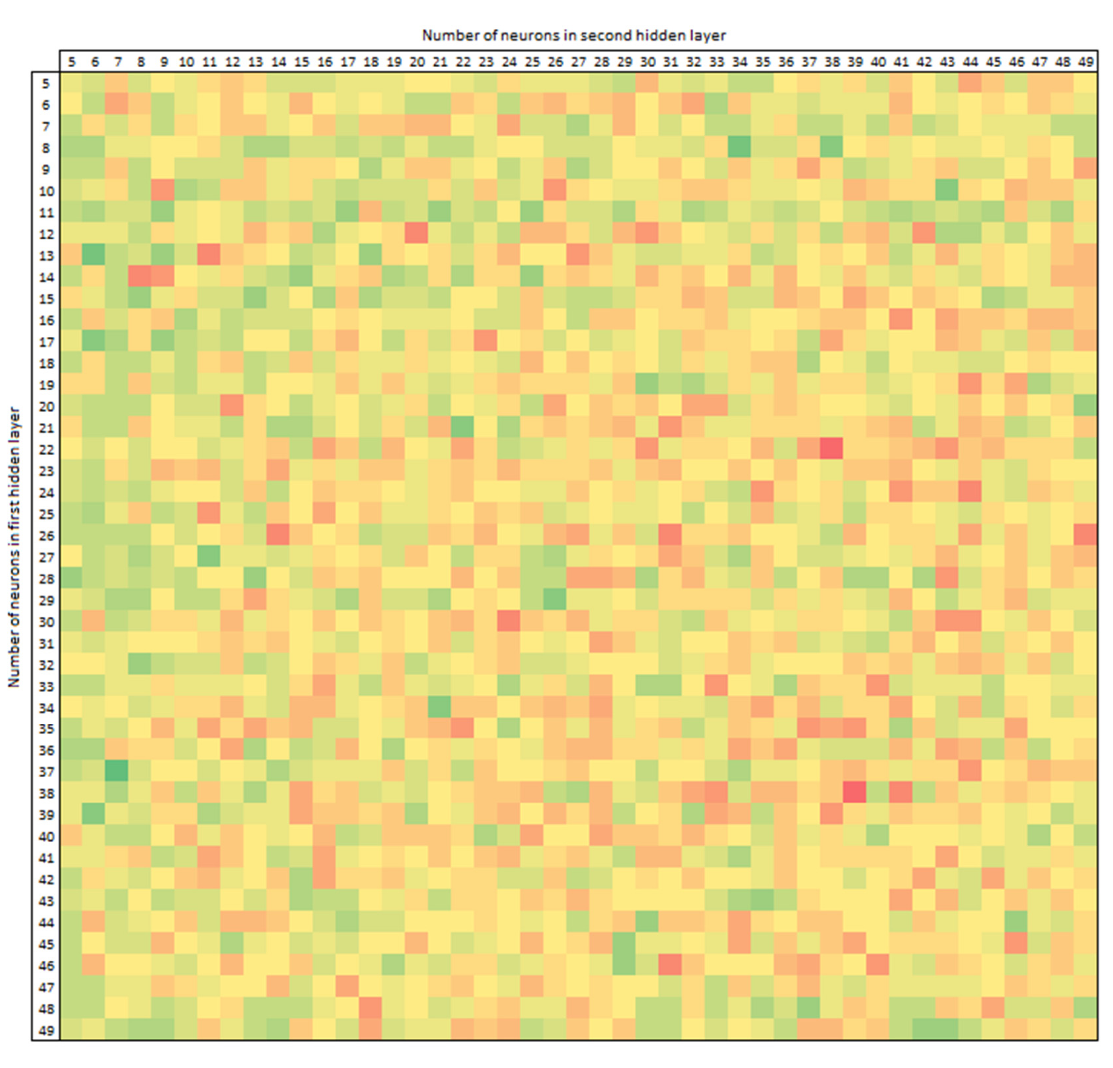
Figure 12. The number in the vertical row is the number of neurons in the first hidden layer, and the number in the horizontal row is the number in the second hidden layer of neurons in an artificial neural network made of perceptrons. The greener the color, the greater the accuracy of the model; the redder, the worse the accuracy.